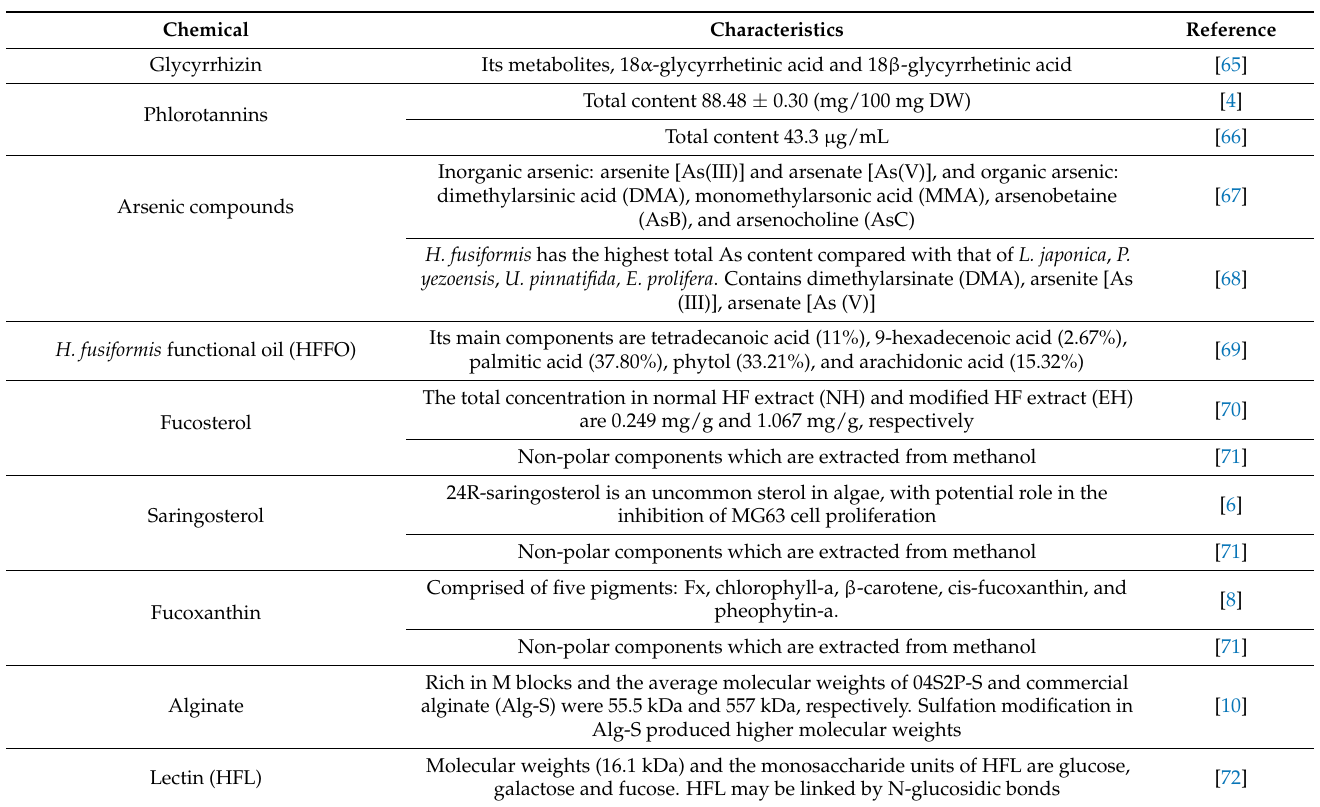
Table 4. Bioactive compounds in H. fusiformis